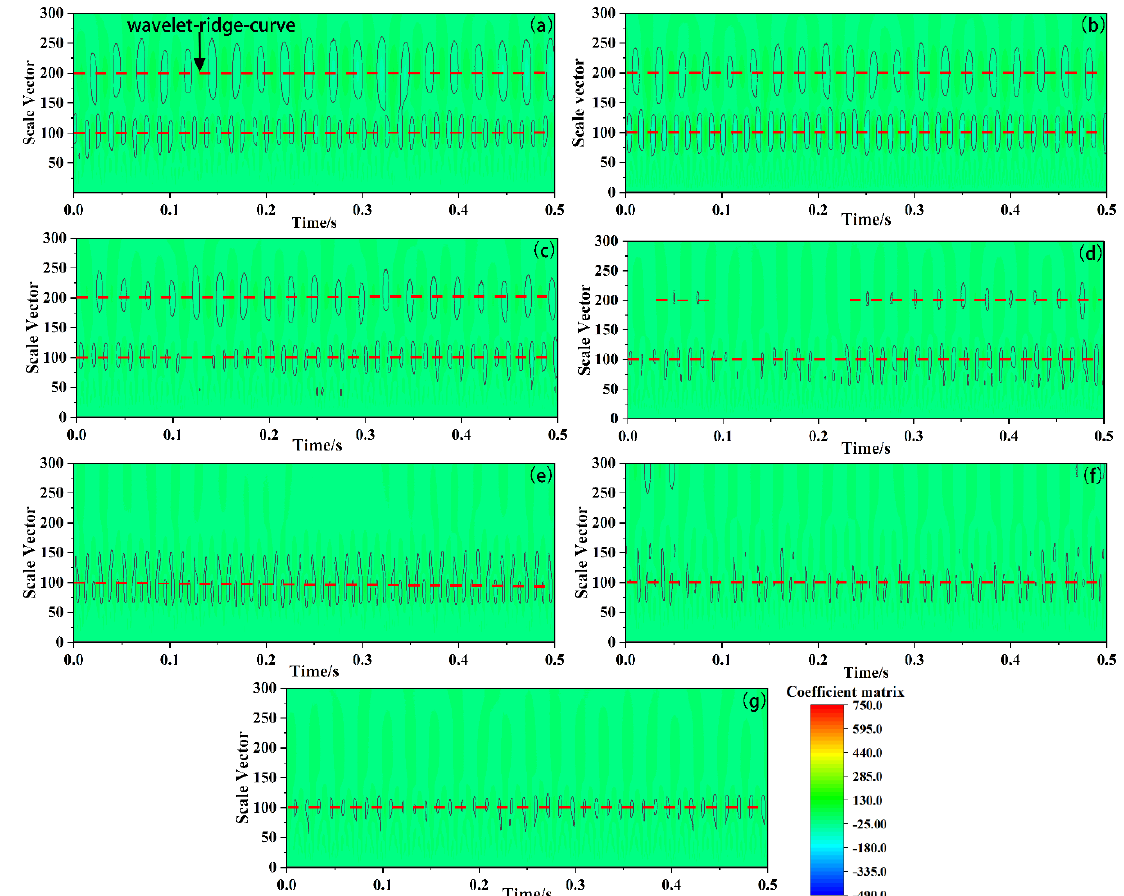
Figure 11. The contour diagram of transform coefficient of weld pool oscillation with different penetration status. Full penetration: ( a ) V = 11 cm / min; ( b ) V = 13.75 cm / min; ( c ) V = 16.5 cm / min. Critical penetration: ( d ) V = 19.25 cm / min. Full penetration: ( e ) V = 24.75 cm / min; ( f ) V = 30.25 cm / min; ( g ) V = 35.75 cm / min.